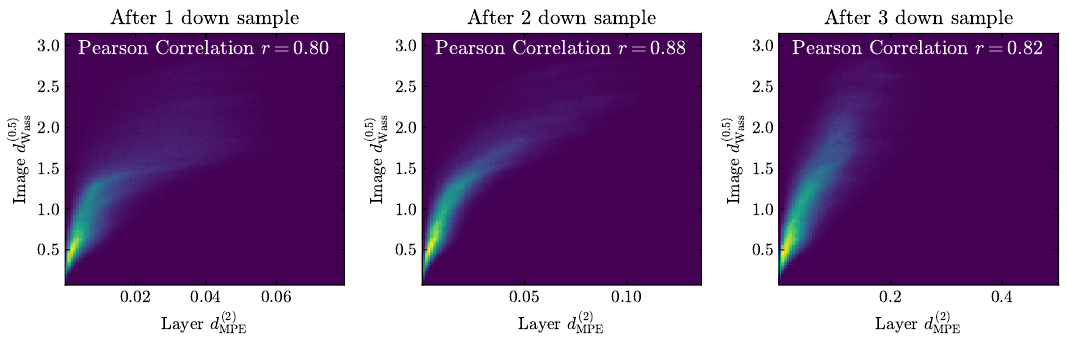
Figure 6 . Correlations of the pair-wise event distance in the image space with the interior activa- tions of the network after different numbers of down sample blocks. This is the same network as in figure 5, but now the image distances use a different power of p . The correlation is higher with p = 0 . 5 than p = 1